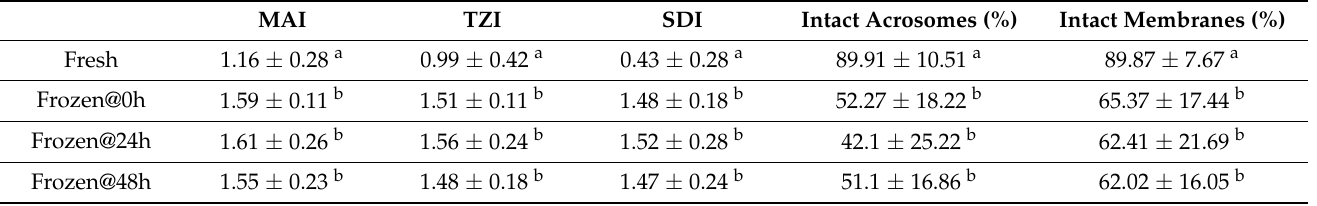
Table 1. Morphological features of ejaculated canine spermatozoa at collection (Fresh), after standard freezing (Frozen@0h), or freezing at different times of storage in a transport box (Frozen@24h and